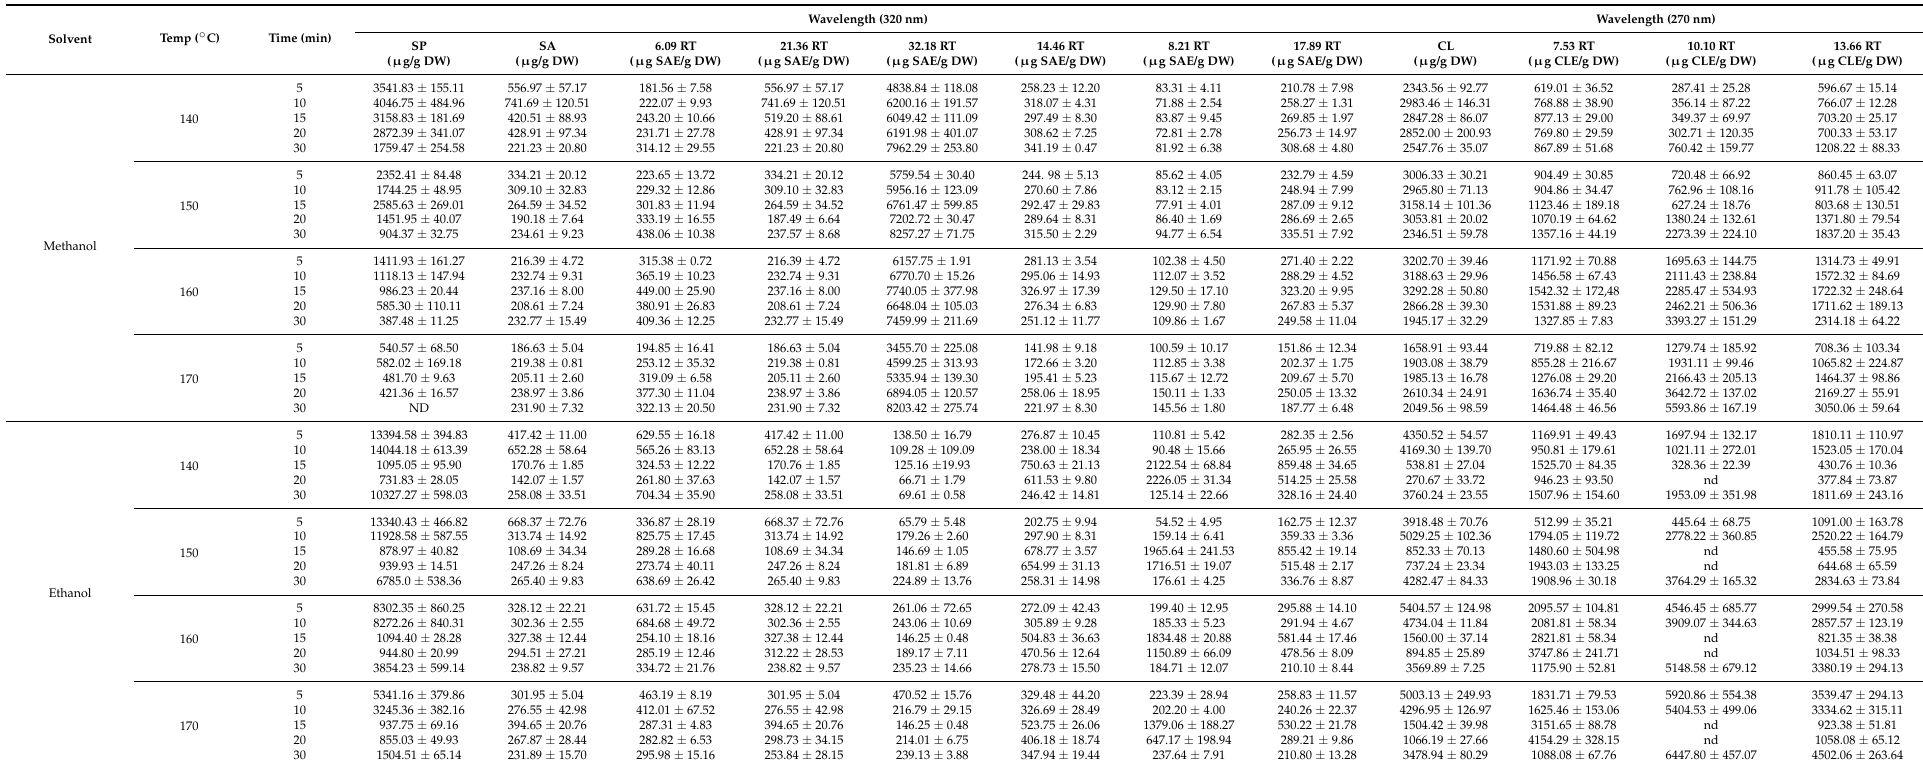
Table 1. Impact of MAE on the major